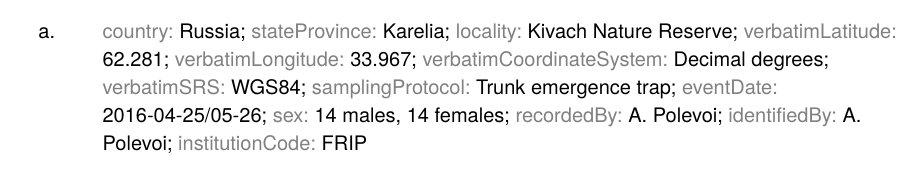
The only representative of the genus Clusiodes with no darkening along the costal vein and entirely black scutum (Fig. 12). Male surstylus fi gured by Mamaev (1974), fi g. 1:3 and Lonsdale and Marshall (2007), fi g. 41.